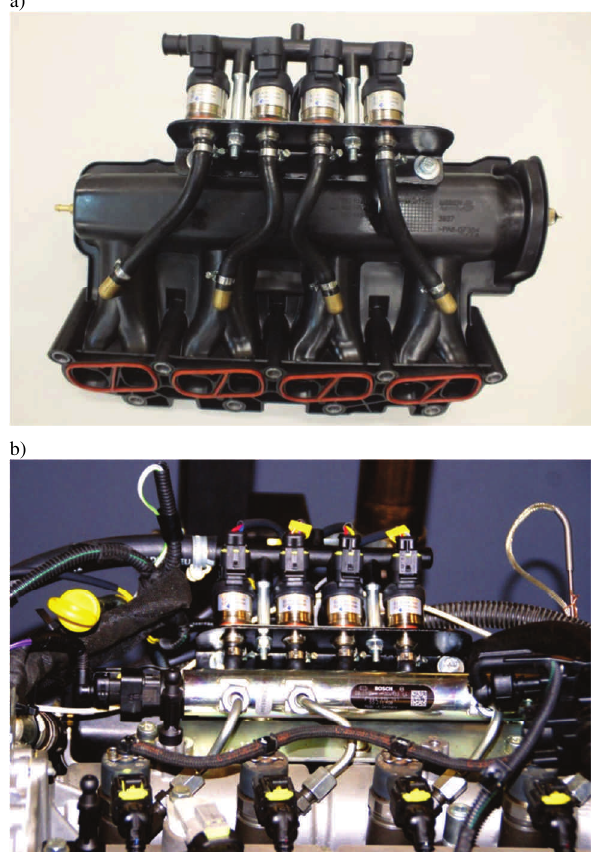
Fig. 1. Intake manifold and test stand of Fiat 1.3 MJT engine:a) intake manifold, b) engine Fiat 1.3 MJT